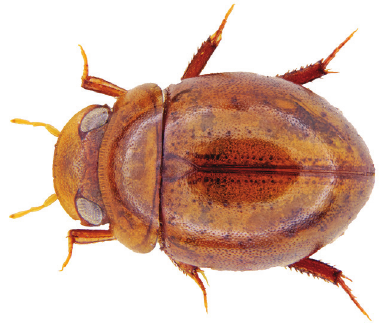
Figure 12. Amphiops uhligi Hebauer, 1995 3.5 mm, iSimangaliso Wetland Park, Eastern Shores (site 14), February 2015 DT Bilton, MS Bird & R Perissinotto